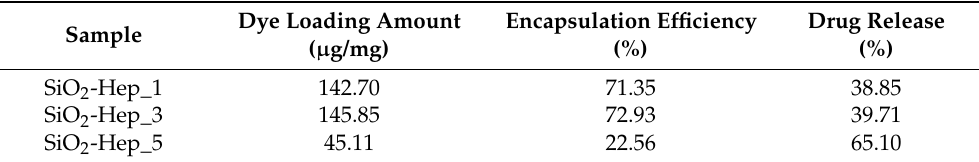
Table 6. Encapsulation efficiency and drug release of RBiso. The reported values fall within the limit values for experimental error of 5%.